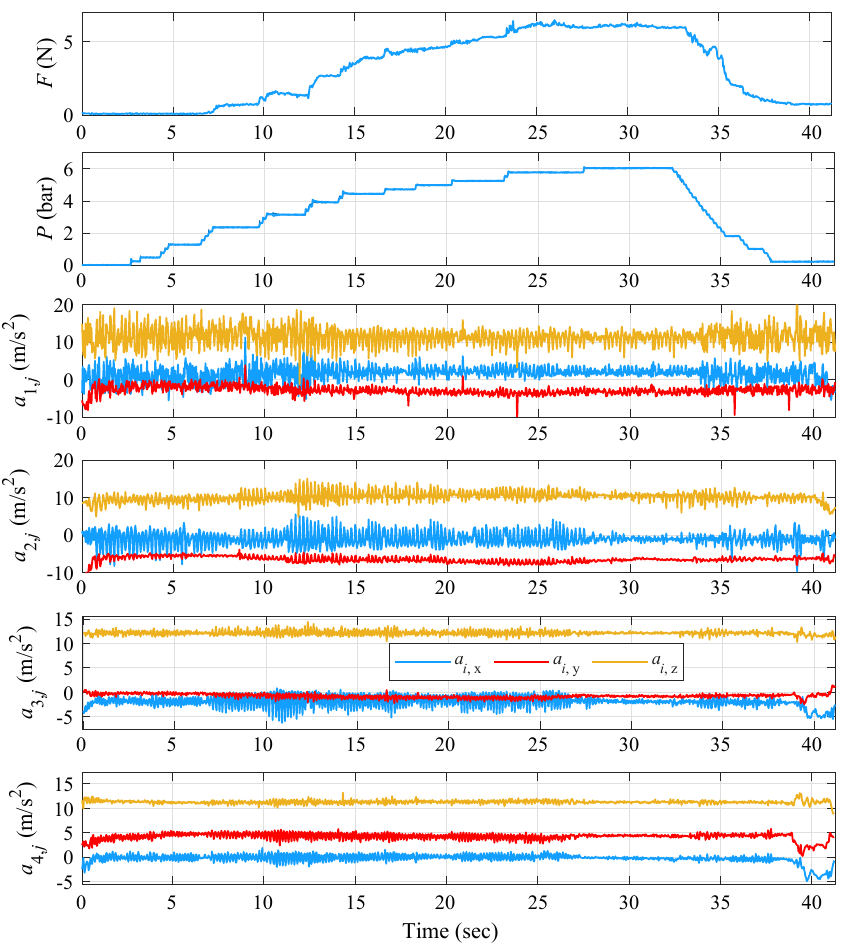
Figure 15. Experimental evaluation of iteration (B) and the effect of applying resisting force on the ET-diagnosed volunteer’s metacarpal under open-loop reference in applied pressure and while the hand is at extended pose; Exp. 1.